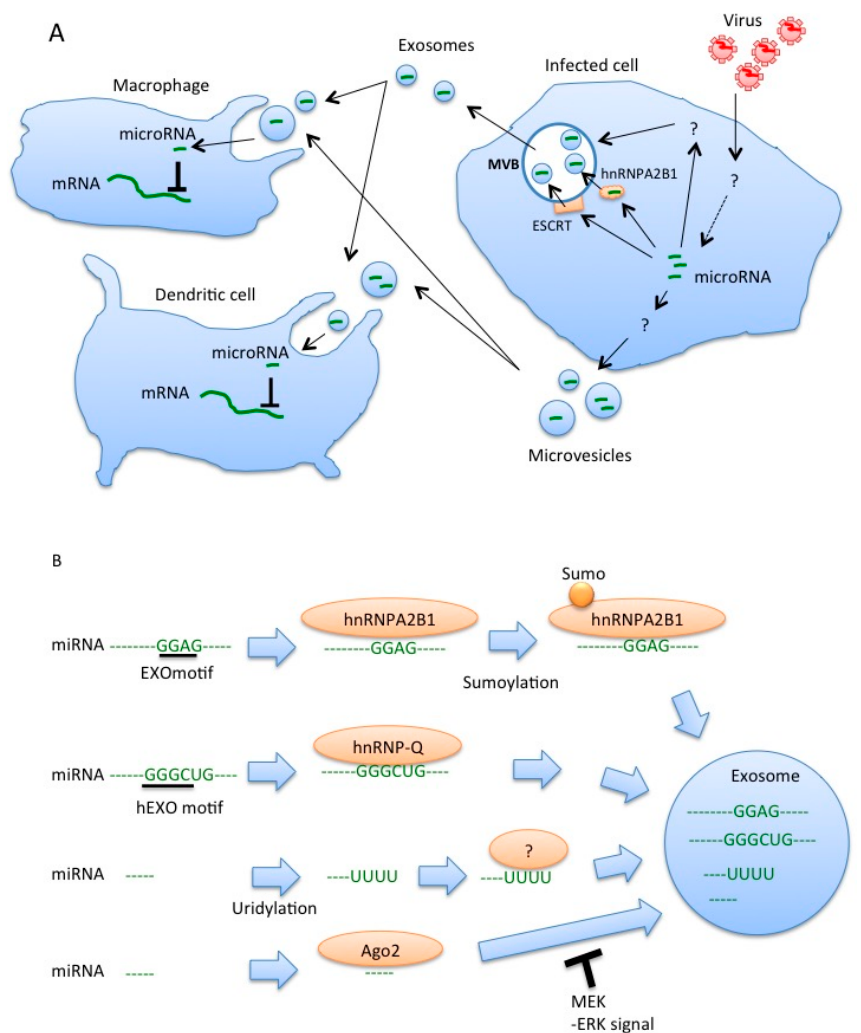
Figure 2. MicroRNAs within the extracellular vesicles regulate the innate immune response. ( A ) miRNAs are sorted into exosomes via the ESCRT complex, hnRNPA2B1, and other proteins. It has been reported that viral infection affects the microRNA levels in EVs. Dendritic cells and macrophages uptake miRNA-containing EVs. Internalized miRNAs are released into the cytoplasm and reduce the target mRNA expression or translation; ( B ) There are several pathways by which cytoplasmic miRNAs are sorted into exosomes. hnRNPs and Ago2 proteins are involved in the miRNA sorting, and post-translational modification of miRNA or proteins associating with miRNAs affect the sorting processes (see main text). MVB, multivesicular bodies. The proteins required for sorting of uridylated miRNA remain unclear.